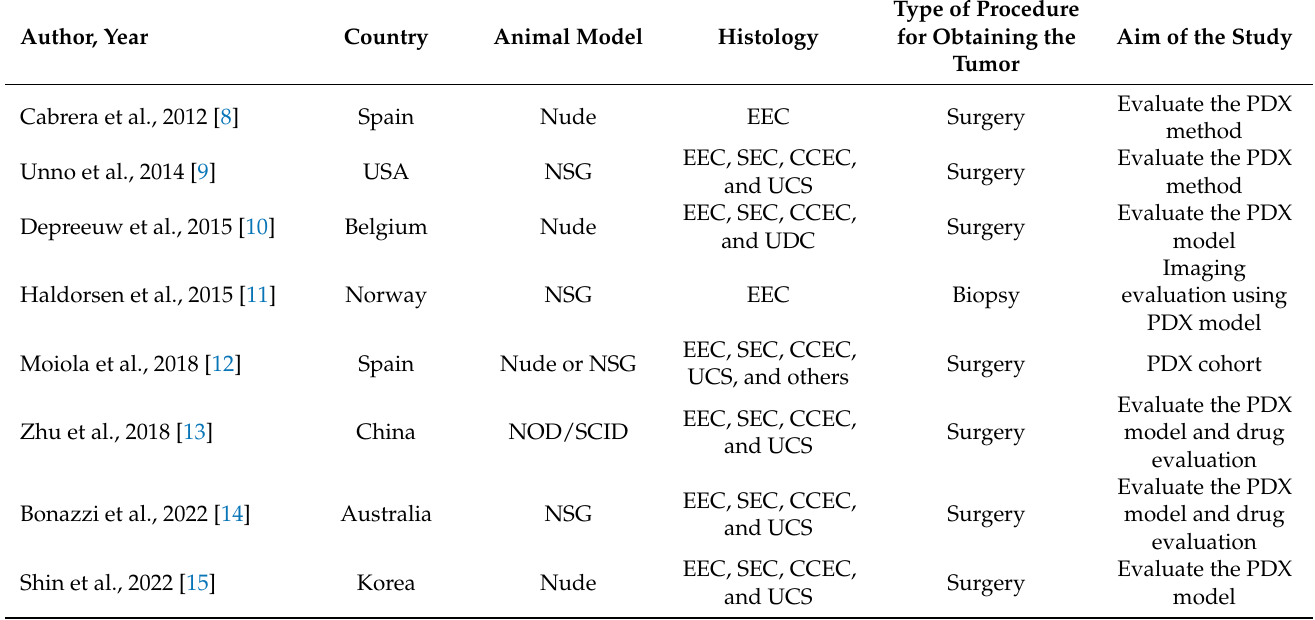
Table 1. Characteristics of endometrial cancer patient-derived xenograft